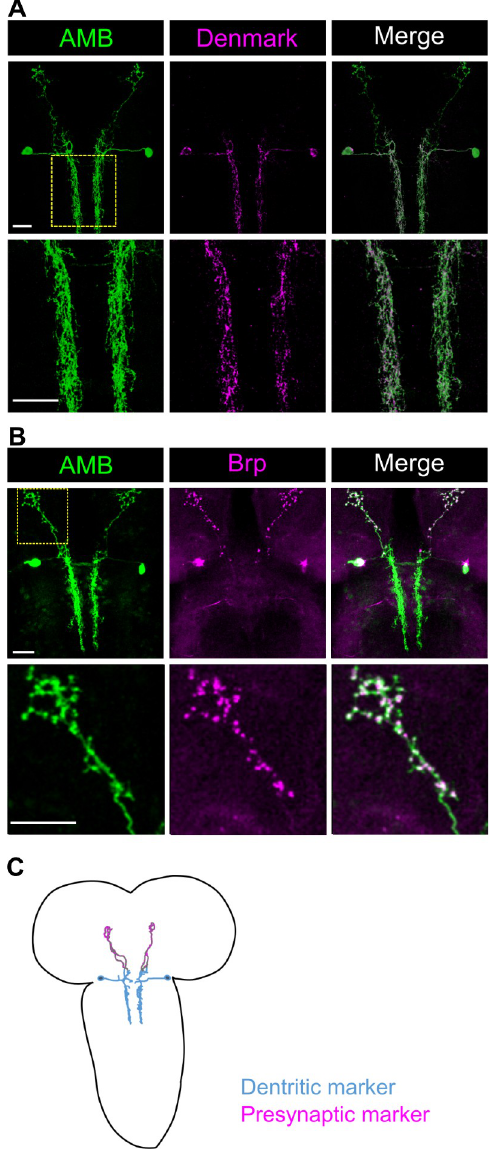
Fig 2. Anatomical characterizations of AMBs. (A, B) The dendritic marker Denmark (A) or the presynaptic marker Brp::mCherry (B) were co-expressed with the membrane-localized GFP in AMBs. The area indicated by yellow dot square was magnified in the lower panels. Genotypes: w ; UAS-mCD8GFP / VGlut-GAL80 [MI04979] ; R60F09-GAL4 / UAS-Denmark (A); w ; UAS-mCD8GFP / VGlut-GAL80 [MI04979] ; R60F09-GAL4 / UAS-brpD3 :: mCherry (B). Scale bar, 20 μ m. (C) A schematic anatomy of AMBs. The color of neurites indicate the soma and the dendritic arbors (blue) and presynaptic site in the axonal processes (magenta), respectively. to the brain (Fig 2A and 2B), indicating that AMBs are ascending neurons that have dendritic arborizations in the SEZ to the T2 segment and extend axonal projections to the brain (Fig 2C). We also analyzed neurotransmitter expression in AMBs and found that AMBs were immunoreactive to the choline acetyltransferase (ChAT), but not to the vesicular glutamate transporter (VGlut) or GABA (Fig 3 and S3 Fig), indicating that AMBs are cholinergic neurons.